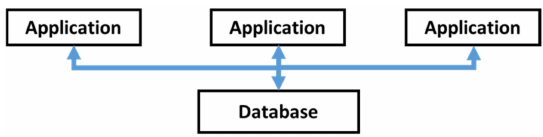
Figure 9. Shared database integration style.